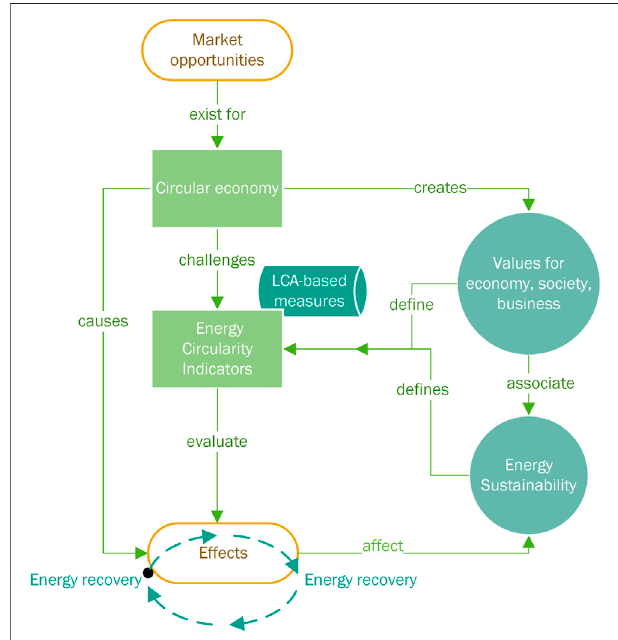
FIGURE 5 | A graphical presentation of the plant ’ s circular business model (own